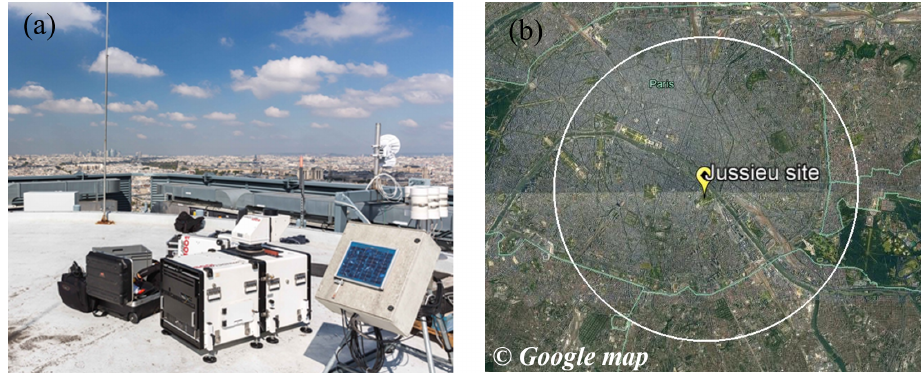
Table 1. Properties of the lidar used for the observation of mlf-cs’s. Doppler lidar (Leosphere WLS100) Altitude of lidar 75ma . g . l . Minimum range 100m Radial-wind-speed range − 30 to 30ms − 1 Laser wavelength 1.543µm Accumulation time